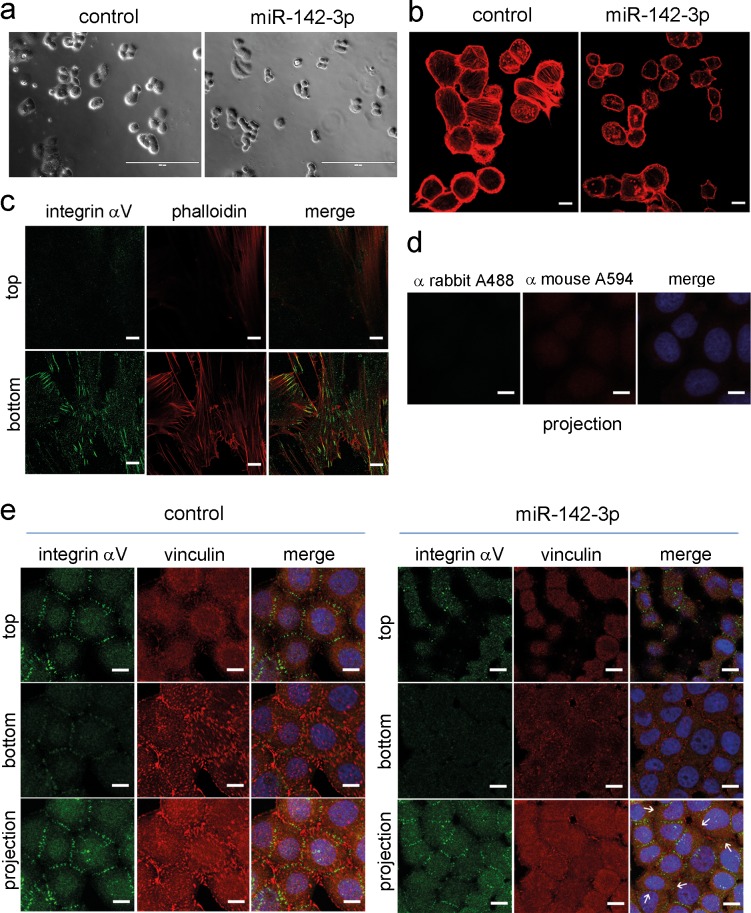
miR-142-3p induces a change in cellular morphology.MDA-MB-468 breast cancer cells were subjected to control precursor or miR-142-3p precursor transfection, and analyzed by phase contrast (a) and confocal immunofluorescence microscopy (b-e). Human skin fibroblasts were analysed for control purposes (c). Shown are phalloidin staining of actin filaments (red), staining of vinculin (red) and staining of Integrin-αV (green). Yellow colour denotes colocalization in merged images, whereas blue colour indicates DAPI nuclear staining in merged panels (d) and (e). (a) phase contrast image shows reduced size of miR-142-3p transfected cells compared to controls (scale bar = 200 μm). (b) miR-142-3p induces a change in cell morphology towards a more rounded shape with fewer membrane protrusions and less actin stress fibers. (see Fig 4). Confocal microscopy analyis of Z-stacks reveals localization of integrin-αV in a focal adhesion-like pattern in human skin fibroblasts (c), whereas a staining in cell-cell-contacts is observed in MDA-MB-468 cells (e). Shown are the top and bottom focal planes and projections. Use of secondary antibodies alone did not generate a signal in MDA-MB-468 cells (d). Compared to controls, miR-142-3p-transfected MDA-MB-468 cells showed a reduced accumulation of integrin-αV in cell-cell contacts (arrows). Scale bar in panels b-e = 10μm.